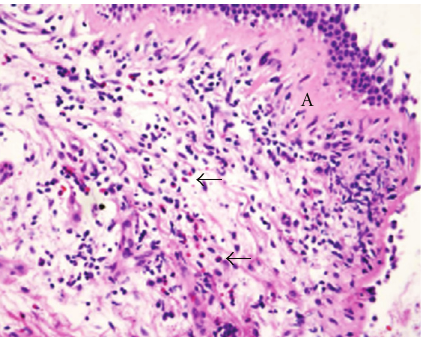
Figure 1: High power photomicrograph of bronchial wall show- ing mucosa with thickened basal membrane (A) and numerous submucosal eosinophils (arrow), including degranulated forms (Hematoxylin and Eosin;